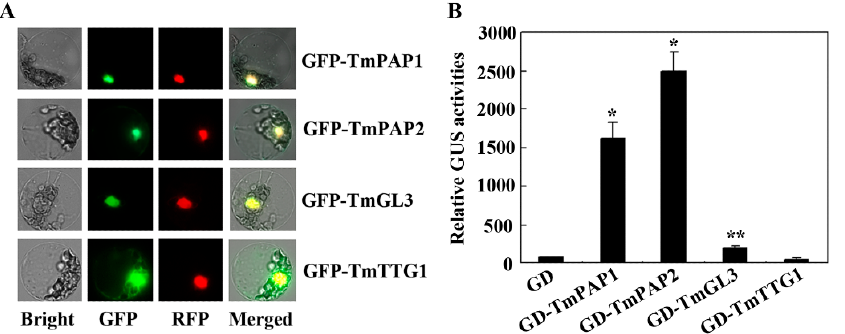
Figure 6. Subcellular localization and transcriptional activity of the nasturtium homologs of the Arabidopsis MBW complex proteins. ( A ) Subcellular localization of the nasturtium homologs of the Arabidopsis MBW complex proteins in Arabidopsis mesophyll protoplasts (with 400 × magnificatio). Plasmids of constructs GFP-TmPAP1 , GFP-TmPAP2 , GFP-TmGL3 , or GFP-TmTTG1 were co-transfected with the nucleus indicator construct NSL-RFP , respectively, into protoplasts, and pictures were taken after the transfected protoplasts were incubated for 20–22 h in darkness. ( B ) Transcriptional activity of the nasturtium homologs of the Arabidopsis MBW complex proteins. Plasmids of the effector constructs GD-TmPAP1 , GD-TmPAP2 , GD-TmGL3 , GD-TmTTG1 or the control construct GD were co-transfected with the reporter construct GAL4:GUS , respectively, into the protoplasts, and GUS activity was assayed after the transfected protoplasts were incubated for 20–22 h in darkness. Data represent mean ± SD of three replicates. Significant differences from the GD control (* p < 0.001, ** p < 0.01).